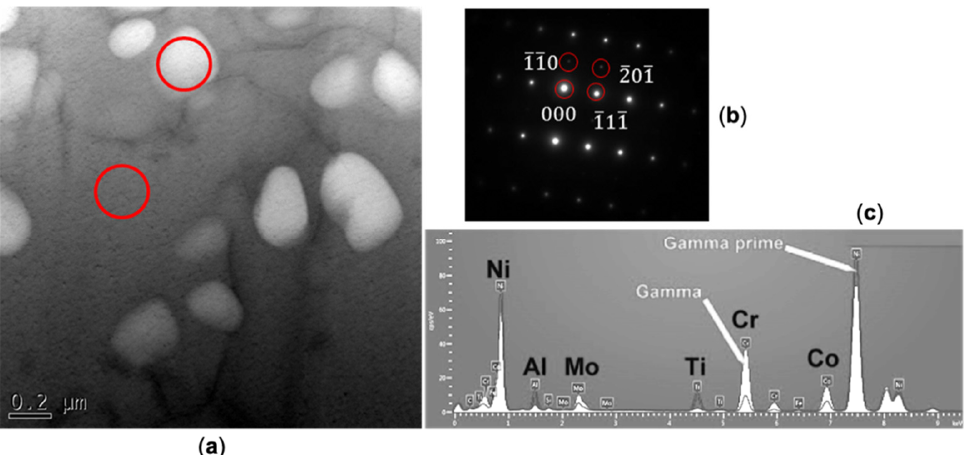
Figure 4. Phase identification of γ ’ precipitates: ( a ) a TEM micrograph of γ ’; ( b ) a superlattice diffraction pattern of γ ’ and ( c ) compared EDS spectra of the γ matrix and the γ ’ particle.